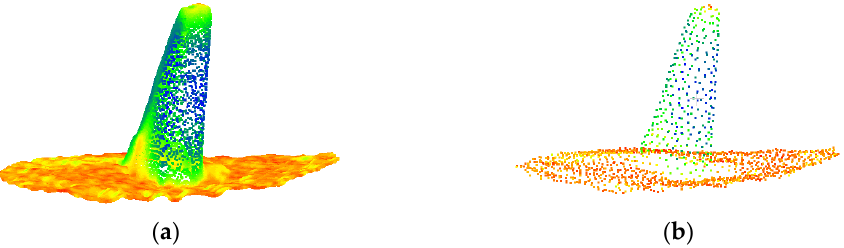
Figure 4. Point cloud containing anchor points. ( a ) Raw point cloud. ( b ) Downsampled point cloud.